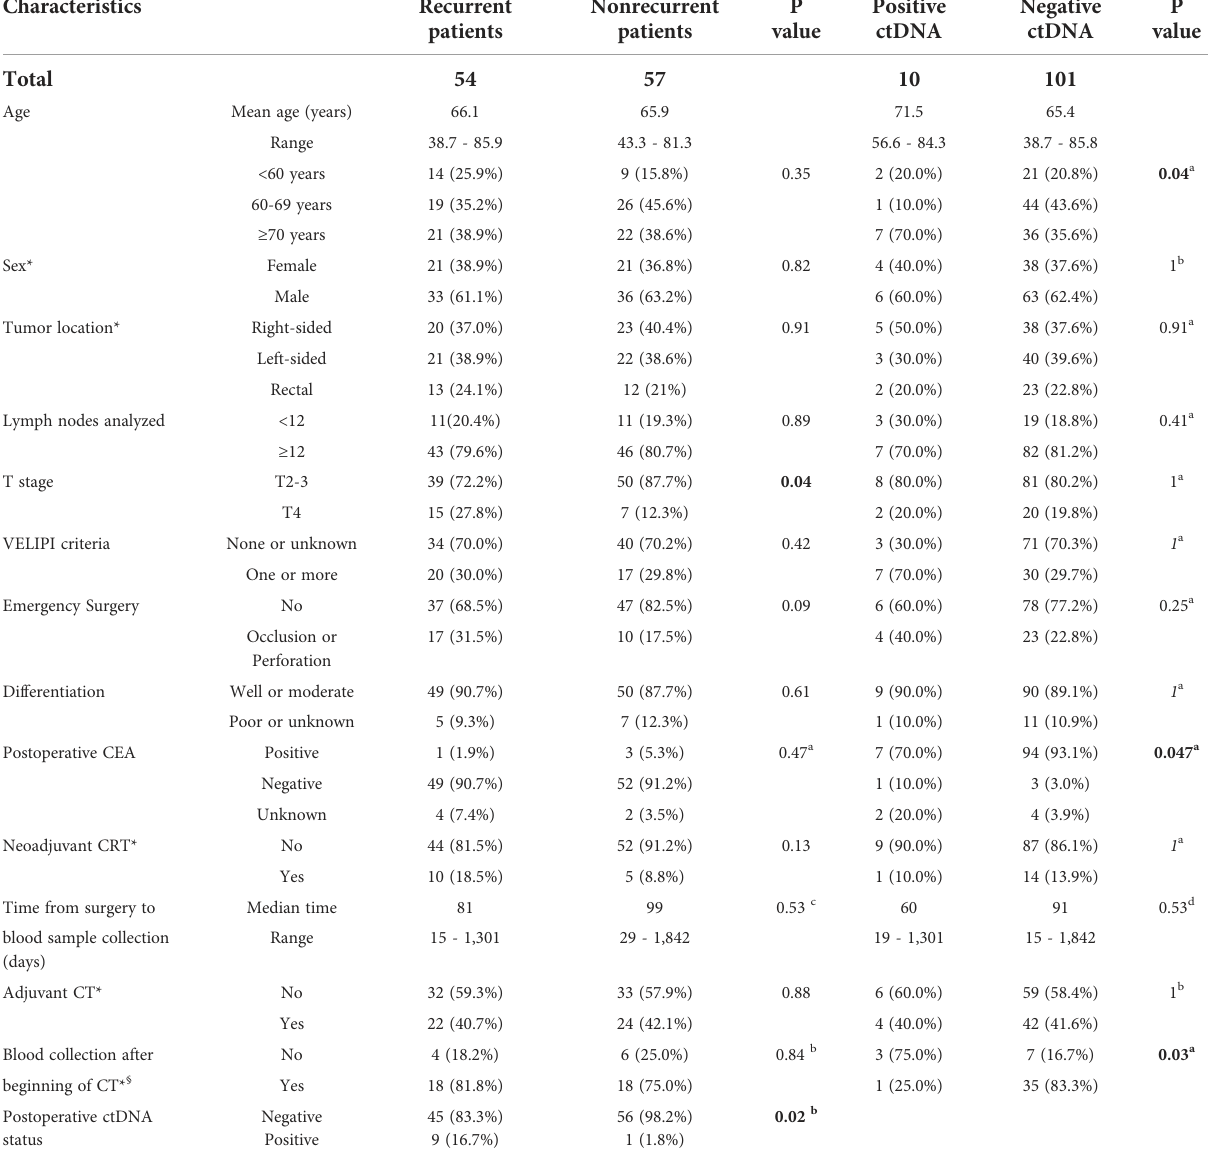
TABLE 1 Main characteristics of stage II CRC resected patients included in the study.